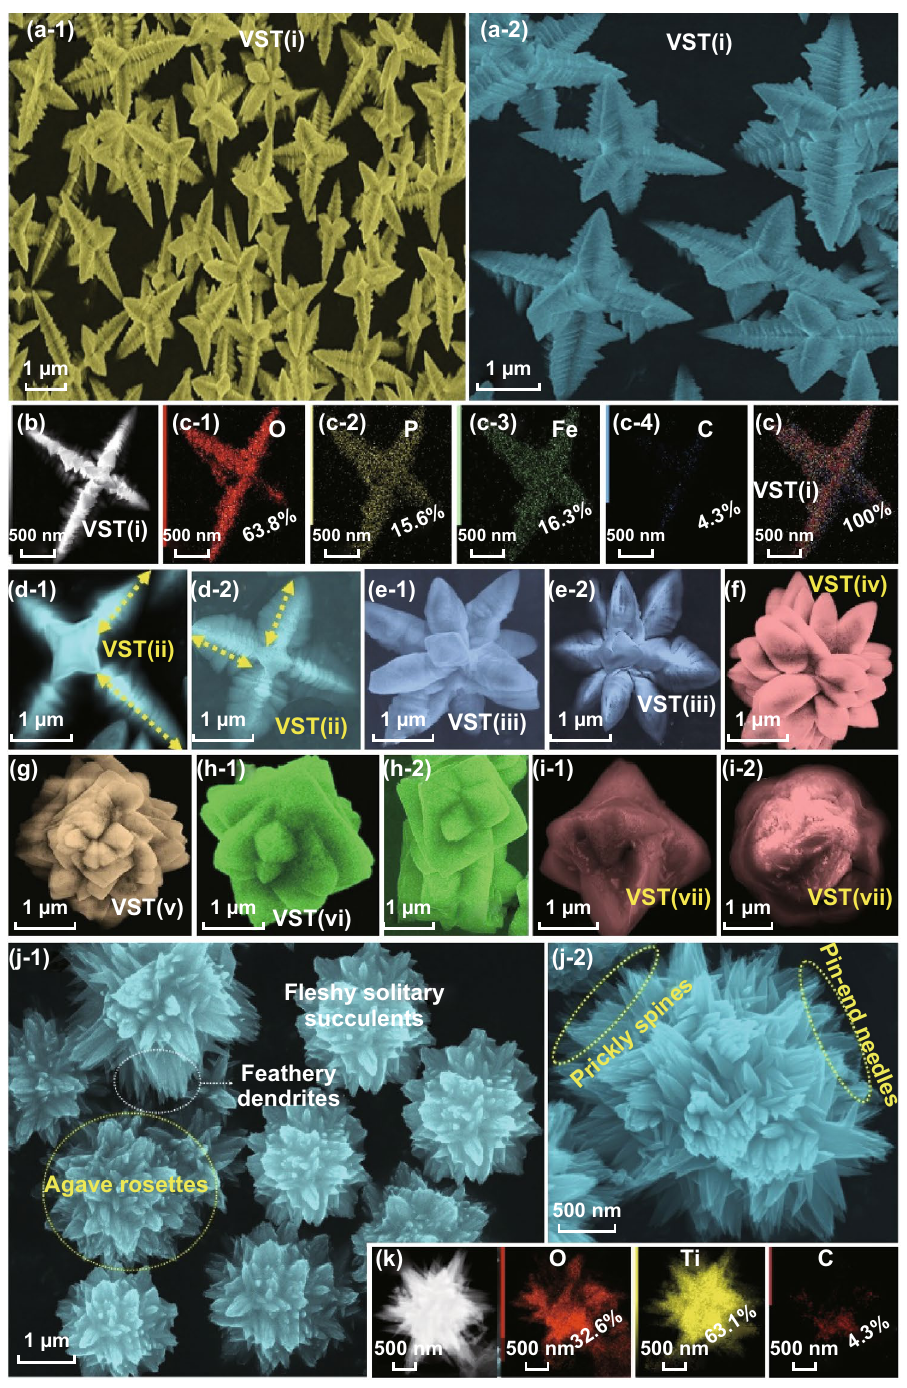
Fig. 1 Low and high‑resolution FE‑SEM images, STEM‑EDS pattern, and elemental mapping of heterogeneous composite superstructures of LiFePO 4 @C (cathode, a – i ) and TiO 2 @C (anode, j – k ) that are designated in vertical‑star‑tower (VST) building blocks and in closely packed flower agave rosettes (FRTO). a , b FE‑SEM and STEM‑EDS images of VST‑(i)@C and ( d1 ‑ 2 ) VST‑(ii)@C superpower hierarchy surfaces. e – i High‑resolution FE‑SEM of the (E)VST‑(iii)@C, (F)VST‑(iv)@C, (G)VST‑(v)@C, (H)VST‑(vi)@C, and ( i ‑ 1 , i ‑ 2 ) VST‑(vii)@C power hierar‑ chies with complex and stacked/condensed super structures blocks featured. j ‑ 1 and j ‑ 2 FE‑SEM images, k Top view, bright field STEM image, and EDS elemental mapping of (FRTO@C) anode morphology that was designated in the flower agave rosettes hierarchy with closely packed solitary succulents, feathery prickly spines, and dendritic fleshy needle‑ended